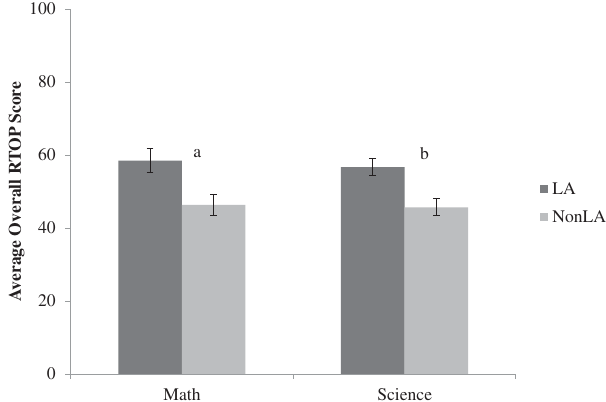
FIG. 1. Overall RTOP scores for LAs and NonLAs disaggre- gated by the subject observed. Error bars represent plus and minus 1 standard error on the mean. (a) p ¼ 0 . 005 and (b) p ¼ 0 . 001 .